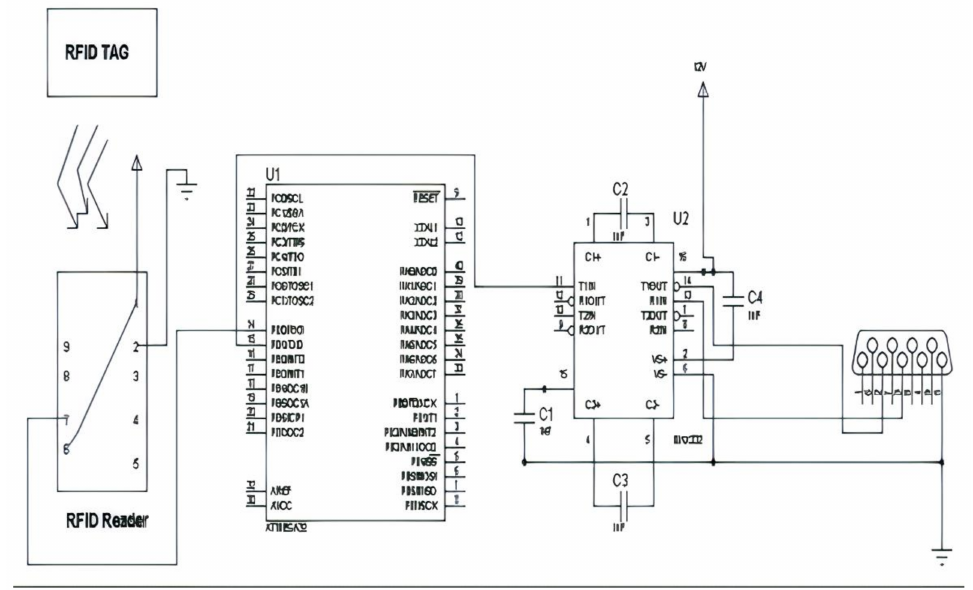
Figure 8. Circuit diagram for RFID code